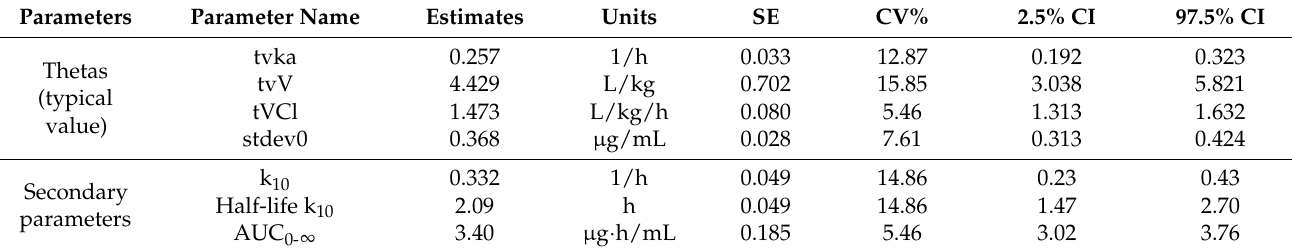
Table 1. Population primary and secondary parameters of orally administered doxycycline hyclate (5 mg/kg) in rabbits at different